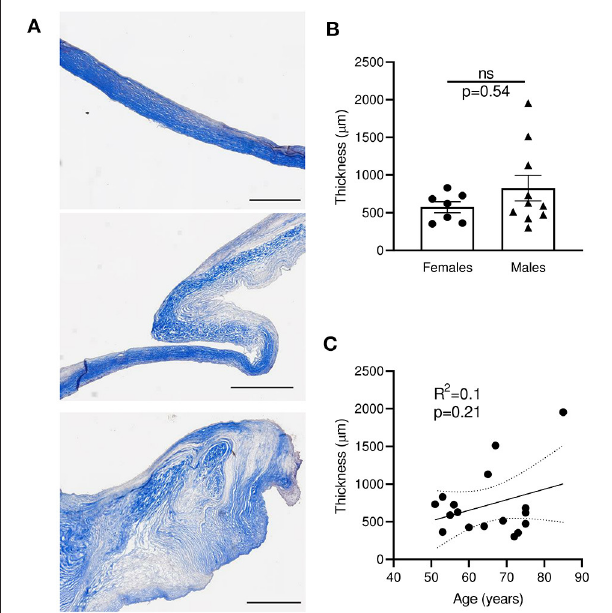
FIGURE 2 | Sections of human MV with MR display large heterogeneity of thickness, independently of age and gender. (A) Histological sections of human mitral valves representative of three different grades of histological remodeling (patients #7, #4, #11, Supplementary Table 2 ), stained with Masson trichrome (scale bar represents 1mm). (B) Thickness of MV leaflet section from male vs. female samples. (C) Correlation between the age of donor and the MV thickness for each donor. Thin dotted line shows the 95% confidence interval. ns, no